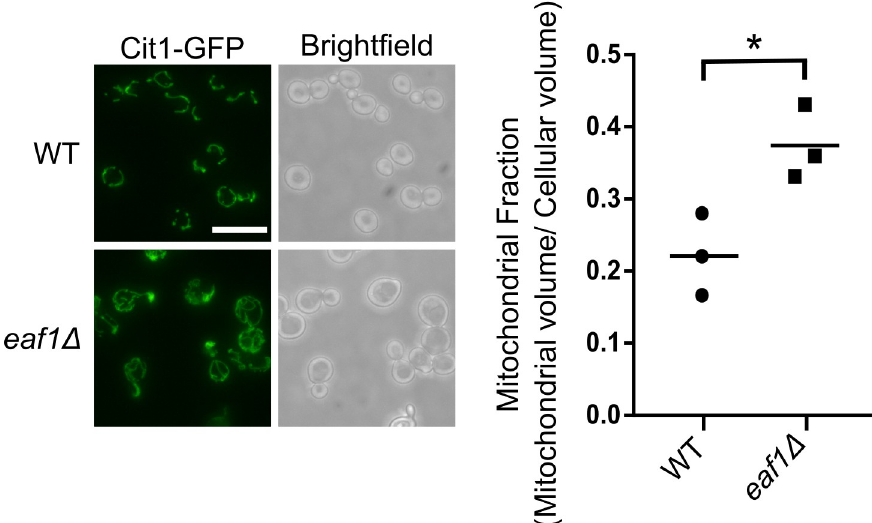
Fig 3. Mitochondrial morphology and volume are altered in NuA4 mutants. Cit1-GFP was used as a marker of the mitochondria to compare WT and eaf1 Δ mitochondrial morphology by fluorescent microscopy. The mitochondrial volume was quantified based on the Cit1-GFP fluorescence using the MitoMap plugin for ImageJ which was then divided by the average total cellular volume of the strain to give the Mitochondrial Fraction (Raw cellular and mitochondrial volume measurements can be found in S7 and S8 Figs). Images are representative of 3 independent biological replicates and at least 50 cells per replicate were analyzed for quantification Scale bar = 10 μ m. An unpaired T-test was run. � = p < 0.05. Horizontal bar in data represents the